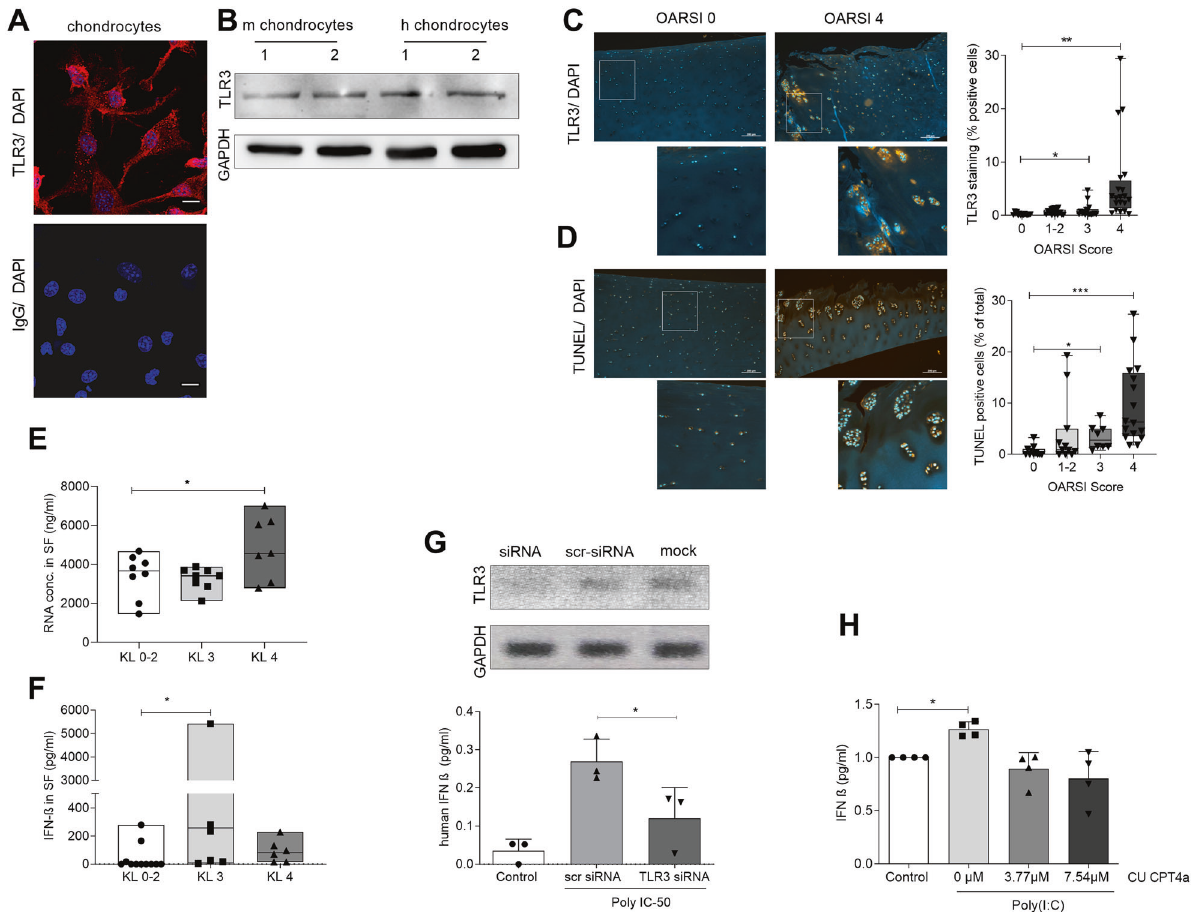
Fig. 2 TLR3 signalling is activated in OA cartilage. A Confocal imaging TLR3 immunostaining (TLR3: red, DAPI: blue) on C28 chondrocytes. B Western Blot for TLR3 in human and murine chondrocytes. GAPDH served as loading control. C TLR3 immunostaining in human OA cartilage. The quanti fi cation of TLR3 staining revealed an increase of staining with increasing OA grade (Scale bar: 200 µm, Kruskal-Wallis test: F (4, 71) = 34.82, p < 0.0001, N > 15), (Dunn ’ s post-hoc, mean rank diff: OARSI 0 vs 1-2: -16. 68 ( p = 0.057); OARIS 0 vs 3: -18.00 ( p = 0.041); OARSI 0 vs 4: -40.68 ( p < 0.0001)). D The quanti fi cation of TUNEL positive cells in OA cartilage samples with different OA grades (Scale bar: 200 µm, Kruskal-Wallis test: F (4, 46) = 22.82, p < 0.0001, N > 8), (Dunns post-hoc, mean rank diff: OARSI 0 vs 1-2: -9.91 ( p = 0.245); OARIS 0 vs 3: -15.13 ( p = 0.045); OARSI 0 vs 4: -24.44 ( p < 0.0001)). E A Ribo Green assay in SF showed that there is more RNA in the synovial fl uid of OA patients with KL score 4 than in healthy controls OA patients with lower KL scores (one-way ANOVA: F (2, 20) = 4.302; p < 0.05, N > 7; KL 0-2: 3408 ng/ ml, KL 3: 3265 ng/ml, KL 4: 4870 ng/ml). F IFN β ELISA in SF of healthy samples and OA patients. (Kruskal-Wallis test: F (4, 38) = 8.39, p = 0.039, N > 6) (Dunn ’ s post-hoc, mean rank diff: OARSI 0-2 vs 3: -10.88 (p = 0.033); OARIS 0-2 vs 4: -5 (p = 0.65). G Semi-quantitative RT-PCR of TLR3 expression in human chondrocytes after treatment with siRNA to mediated TLR3 (upper panel). GAPDH is used as loading control. The graph below shows the poly(I:C)-induced IFN β production in ELISA of siRNA treated chondrocytes compared to scrambled (scr) RNA-treated